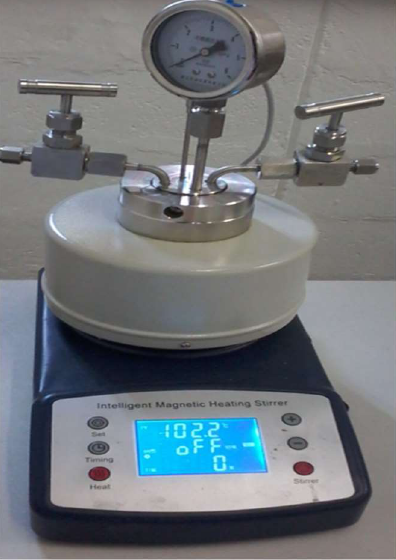
Figure 3. The hydrothermal carbonization reactor.